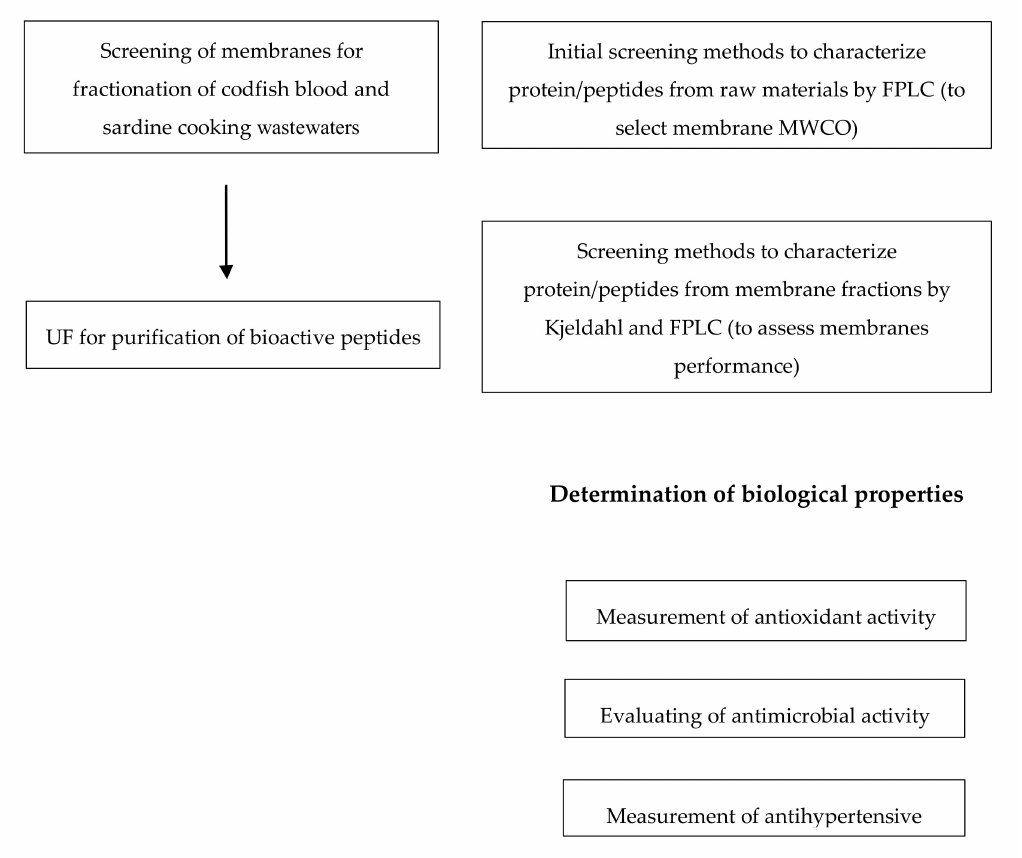
Figure 1. Flow diagram summarizing the experimental studies performed in this